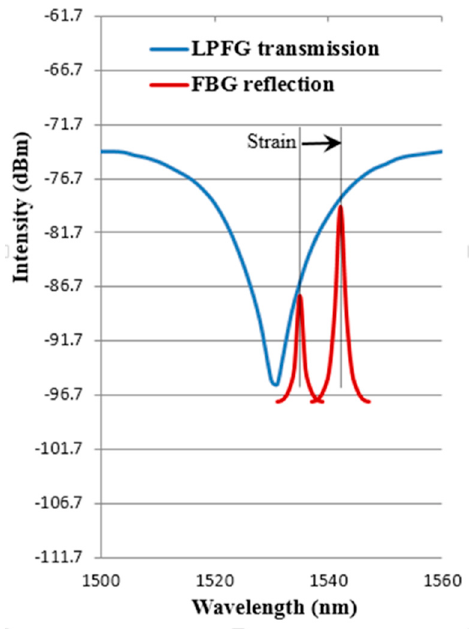
Figure 5. Schematic diagram of FBG-LPFG spectra.